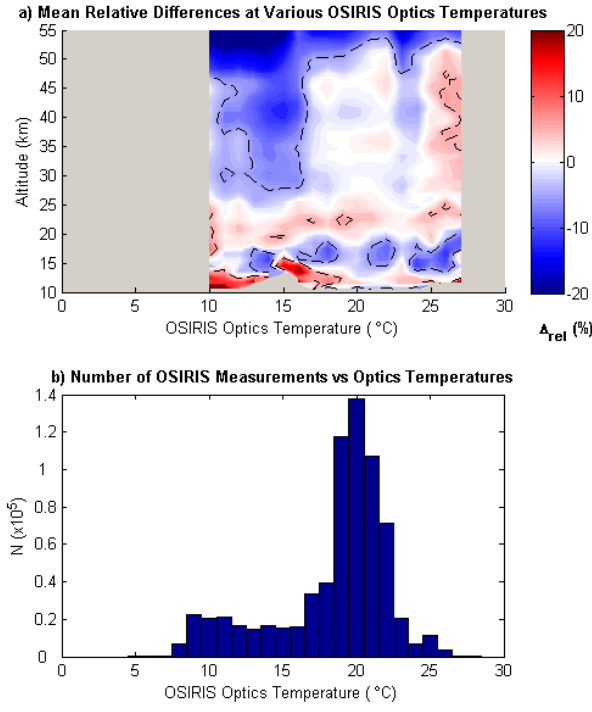
Fig. 9. Variation in relative differences for OSIRIS minus SAGE II at various OSIRIS optics temperatures. (a) Contours of mean rela- Figure 9: Variation in relative differences for OSIRIS minus SAGE II at various OSIRIS 2 tive differences (color-scale) calculated for 1 ◦ C OSIRIS optics tem- optics temperatures. (a) Contours of mean relative differences (color-scale) calculated for 1 3 perature bins (x-axis) at various altitudes (y-axis). The black dashed °C OSIRIS optics temperature bins (x-axis) at various altitudes (y-axis). The black dashed 4 lines indicate ± 5% mean relative difference. The grey shading indi- lines indicate ±5% mean relative difference. The grey shading indicates regions for which 5 cates regions for which there are fewer than 10 coincidences. Mea- surement pairs were selected with broad coincidence criteria (see there are fewer than 5 coincidences. Measurement pairs were selected with broad coincidence 6 Table 1). (b) Number of OSIRIS measurements (y-axis) at various criteria (see Table 1). (b) Number of OSIRIS measurements (y-axis) at various optics 7 optics temperatures (x-axis) for the entire processed dataset (2001– temperatures (x-axis) for the entire processed dataset (2001-2012). 8